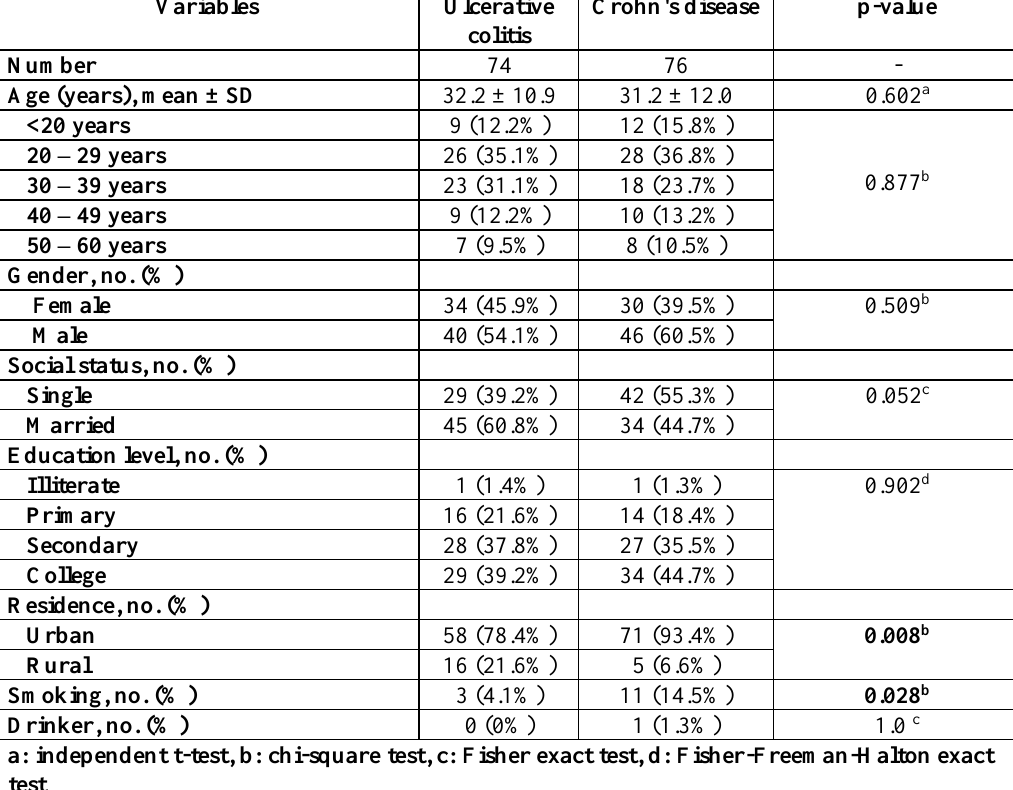
Table 1. Comparison of socio-demographic between both types of IBD